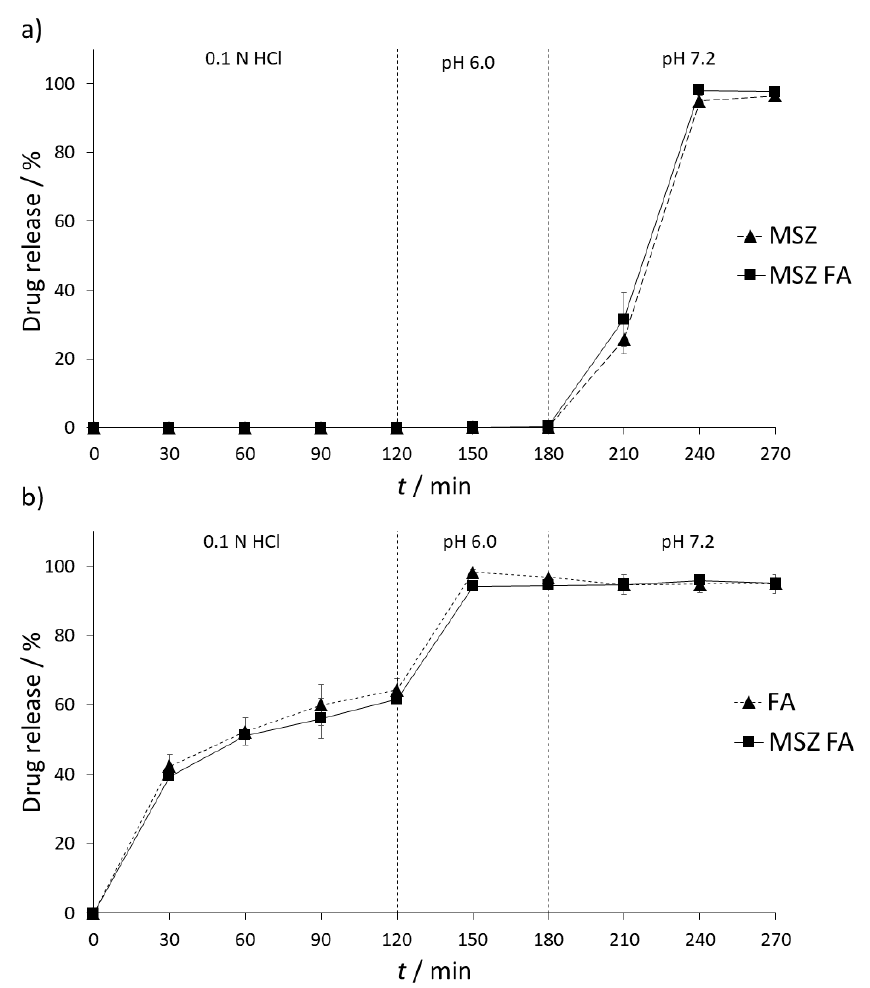
Figure 5. Drug release profiles of: ( a ) MSZ and ( b ) FA alone and in combination in different dissolution media ( n = 3).